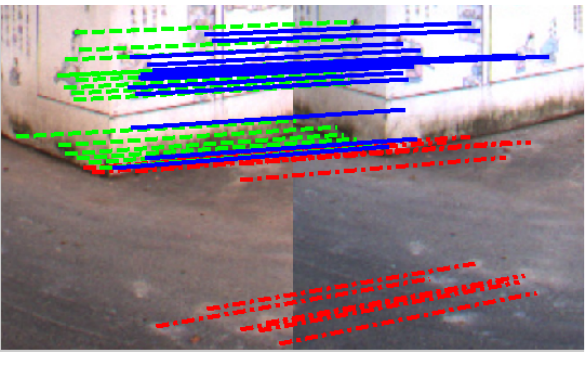
Figure 8. A portion of matched features on the trihedron. The matched feature pairs on the three planes are marked with lines in different styles.